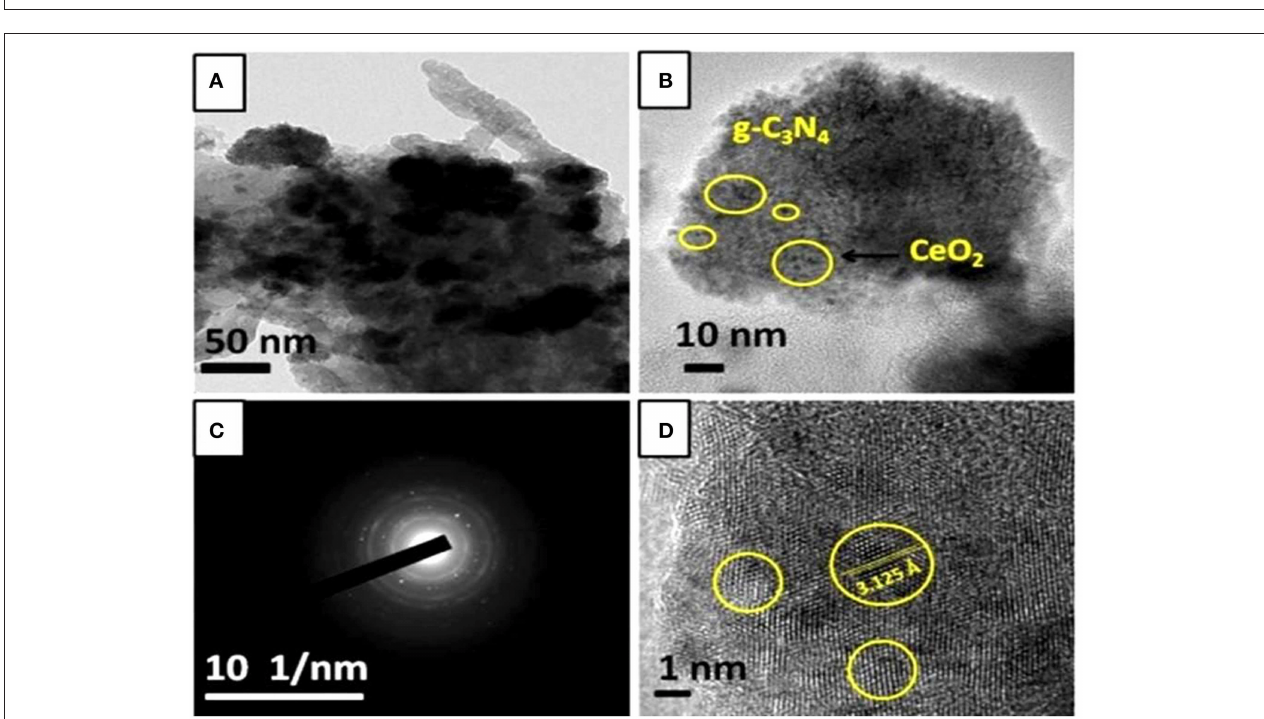
electrode of surface area (0.07067 cm 2 ). The modified glassy carbon electrode was dried in a vacuum oven for 3 h. About